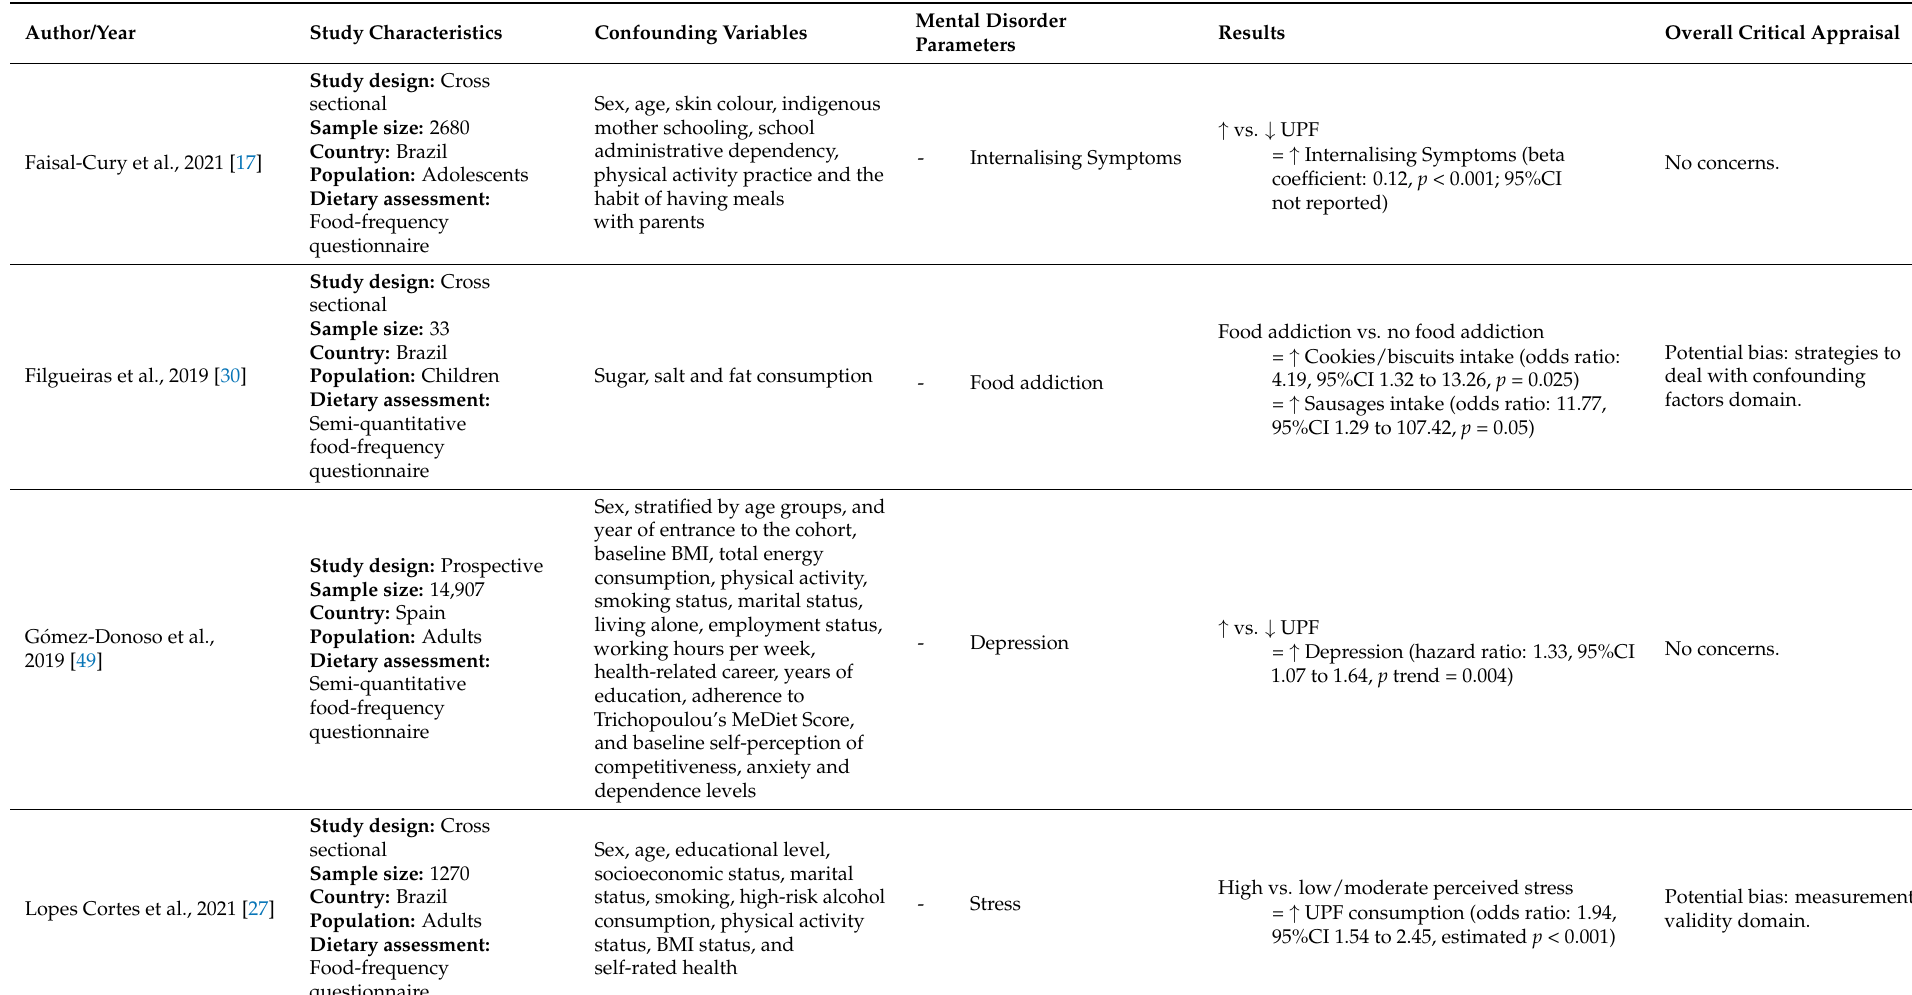
Table 1. Study characteristics and key